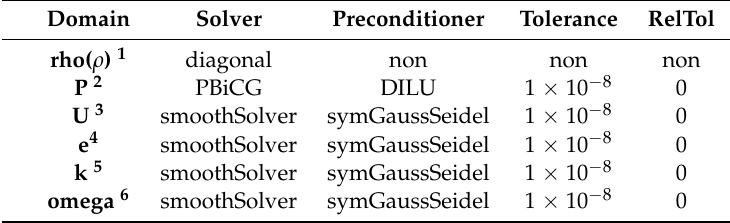
Table 3. fvSolution contains a series of sub-dictionaries to afford the necessary info for the solvers’ running.